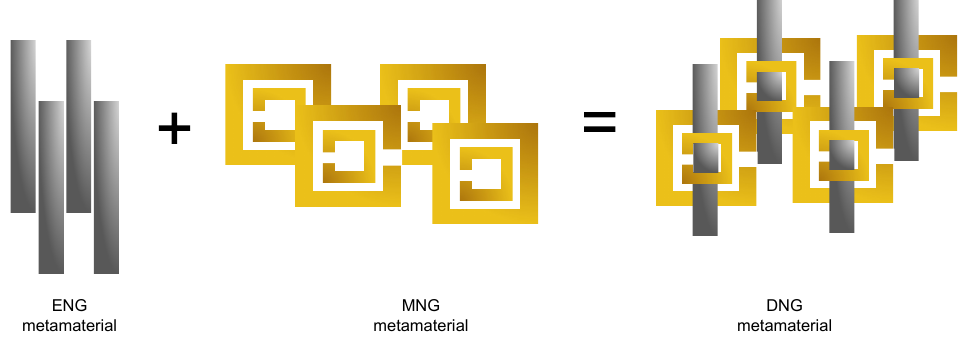
Figure 3. Creating DNG metamaterials by combining wires and